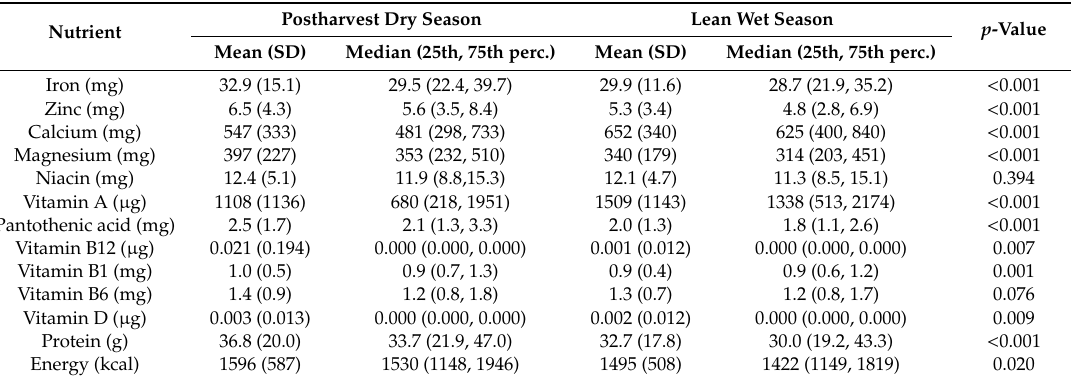
Table 4. Seasonal variation in nutrient intakes in postharvest dry and lean wet seasons (N = 577) computed by NutriSurvey